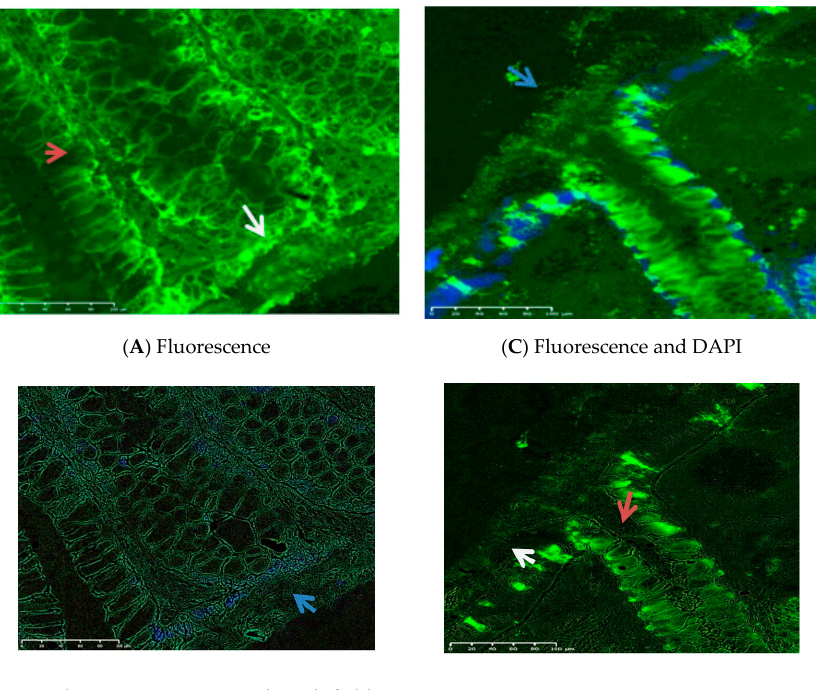
Figure 2. MUC2 staining of colonic mucosa. These images represent the immuno- and DAPI fluorescent stained mucus of the colon sigmoideum from two different subjects. Images ( A ) and ( B ) are from subject 1, and ( C ) and ( D ) are from subject 2. The mucus is stained in green using Anti-MUC2 antibody (Ccp58) (ab118964) in all images. In subject 1: Image ( A ) represents the fluorescence immunostaining of the mucus (green). The white arrow indicates the inner mucus from the apical membrane side. The red arrow is located in a colonic crypt and indicates the colonic goblet cells; Image ( B ) represents the fluorescent immunostaining of the mucus (green), DAPI staining of mononuclear cells (blue), where the Brightfield filter was applied. The blue arrow indicates the luminal side of the inner mucus surface. In subject 2, image ( C ) represents the fluorescence immunostaining of the mucus (green) and DAPI staining of mononuclear cells (blue). The blue arrow indicates the luminal side of the inner mucus surface; Image ( D ) represents the fluorescent immunostaining of the mucus (green) where the Brightfield filter was applied. The white arrow indicates the inner mucus from the apical membrane side. The red arrow is located in a colonic crypt and indicates the colonic goblet cells. Scale bar: 100 μ m in all images.